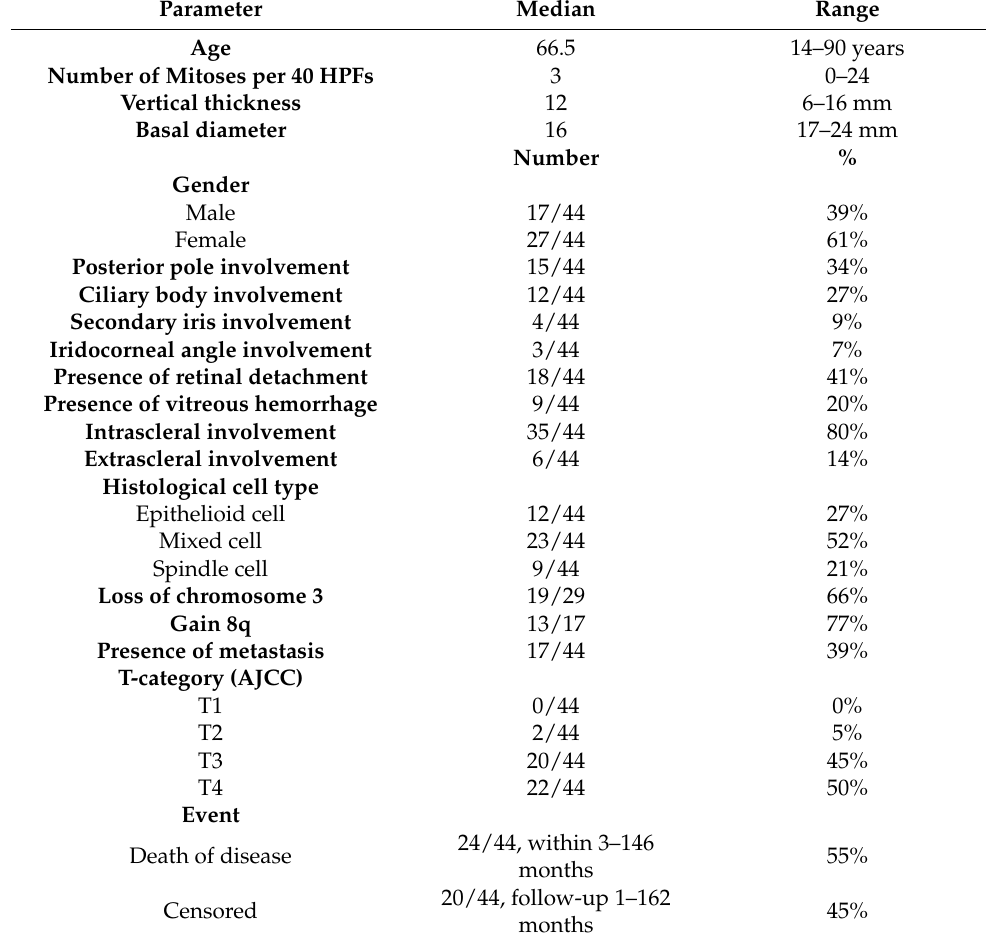
Table 1. Clinicopathological characteristics of 44 patients with